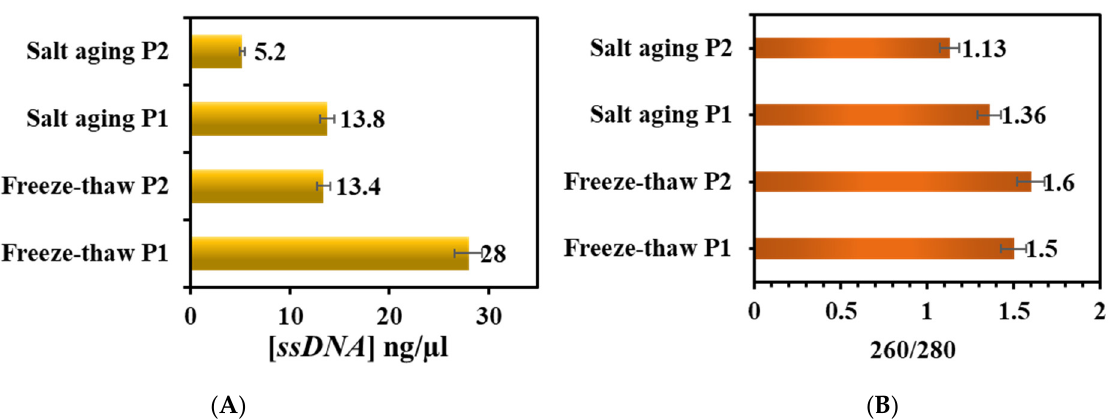
Figure 5. Optical density measurements showing ssDNA ( A ) concentration and ( B ) purity values upon immobilization on AuNPs ‐ dansyl.